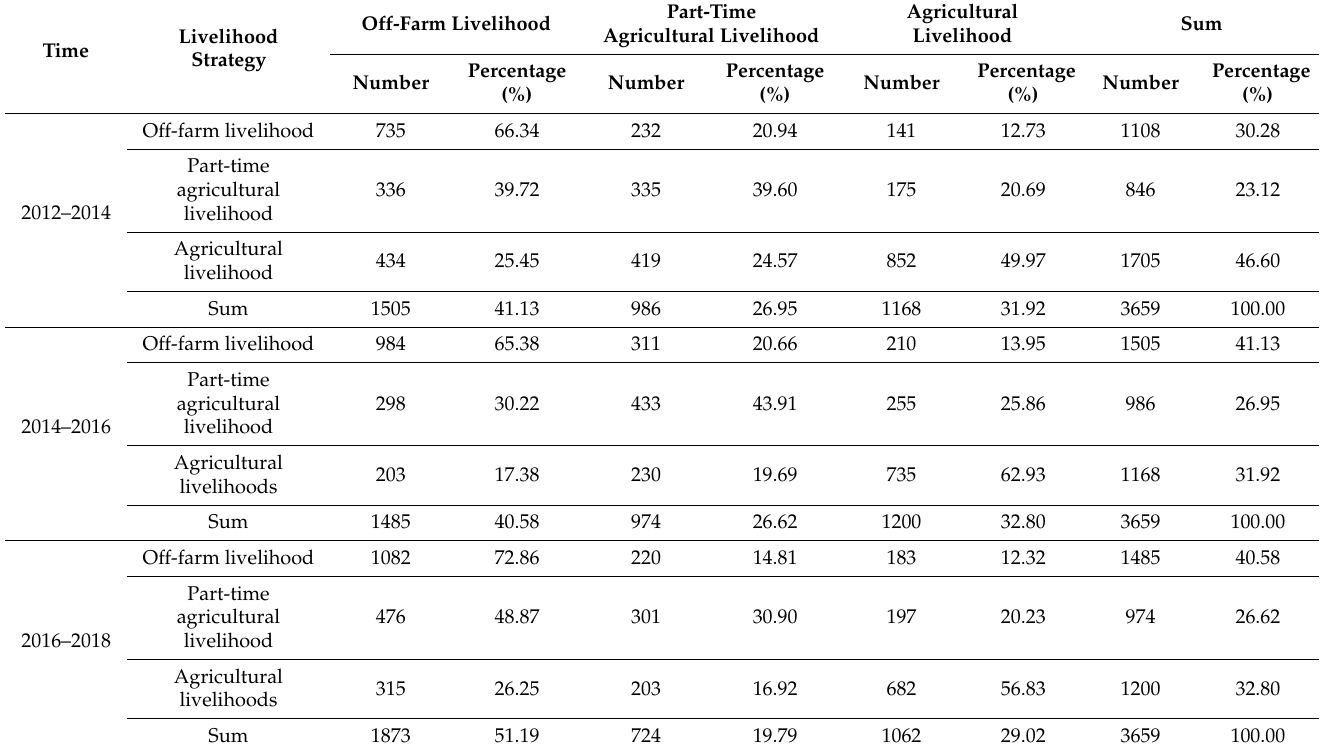
Table 3. Transition probability matrix of household livelihood strategy changes (2012–2018).